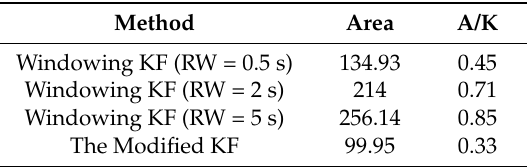
Table 1. Performance analysis using an evaluation metric